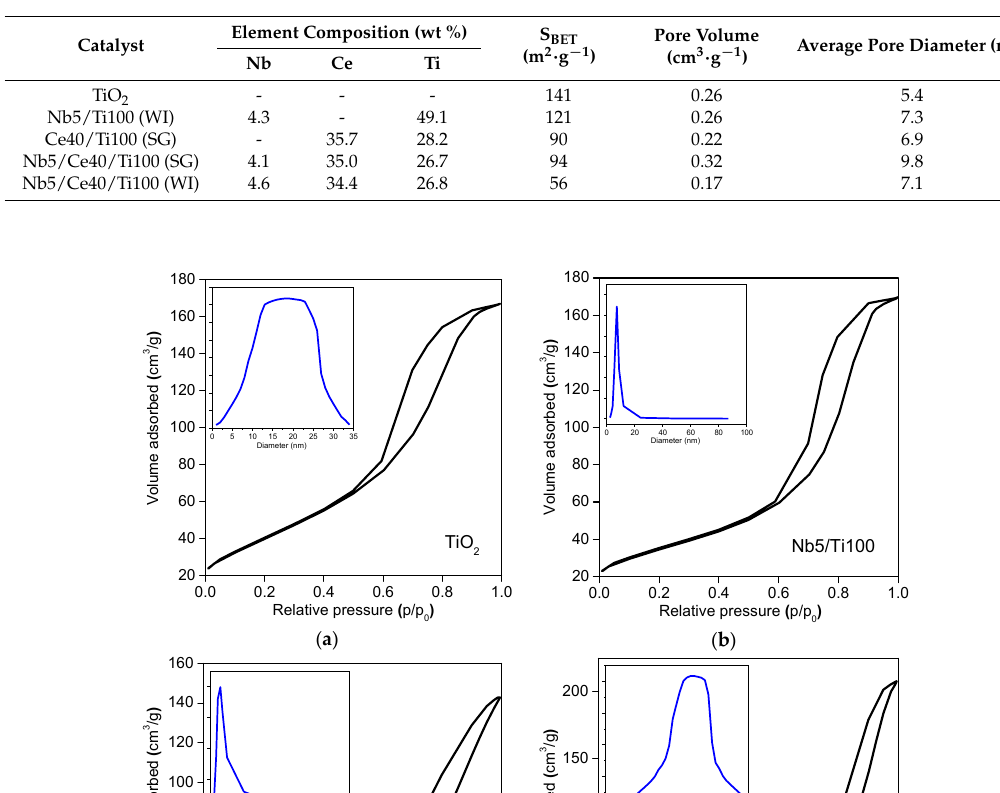
Table 1. Catalyst composition, specific BET surface area, and pore volume (SG = sol-gel route; WI = wet impregnation).